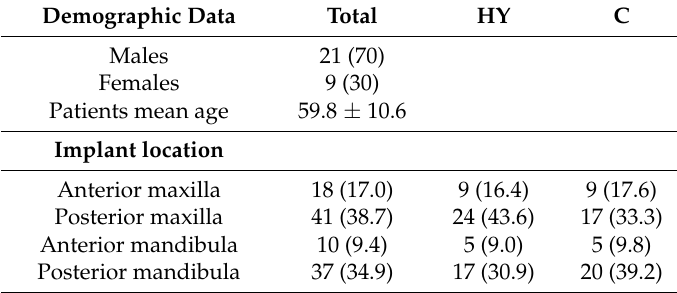
Table 3. Demographic data and implant location. Data in absolute values and (%).